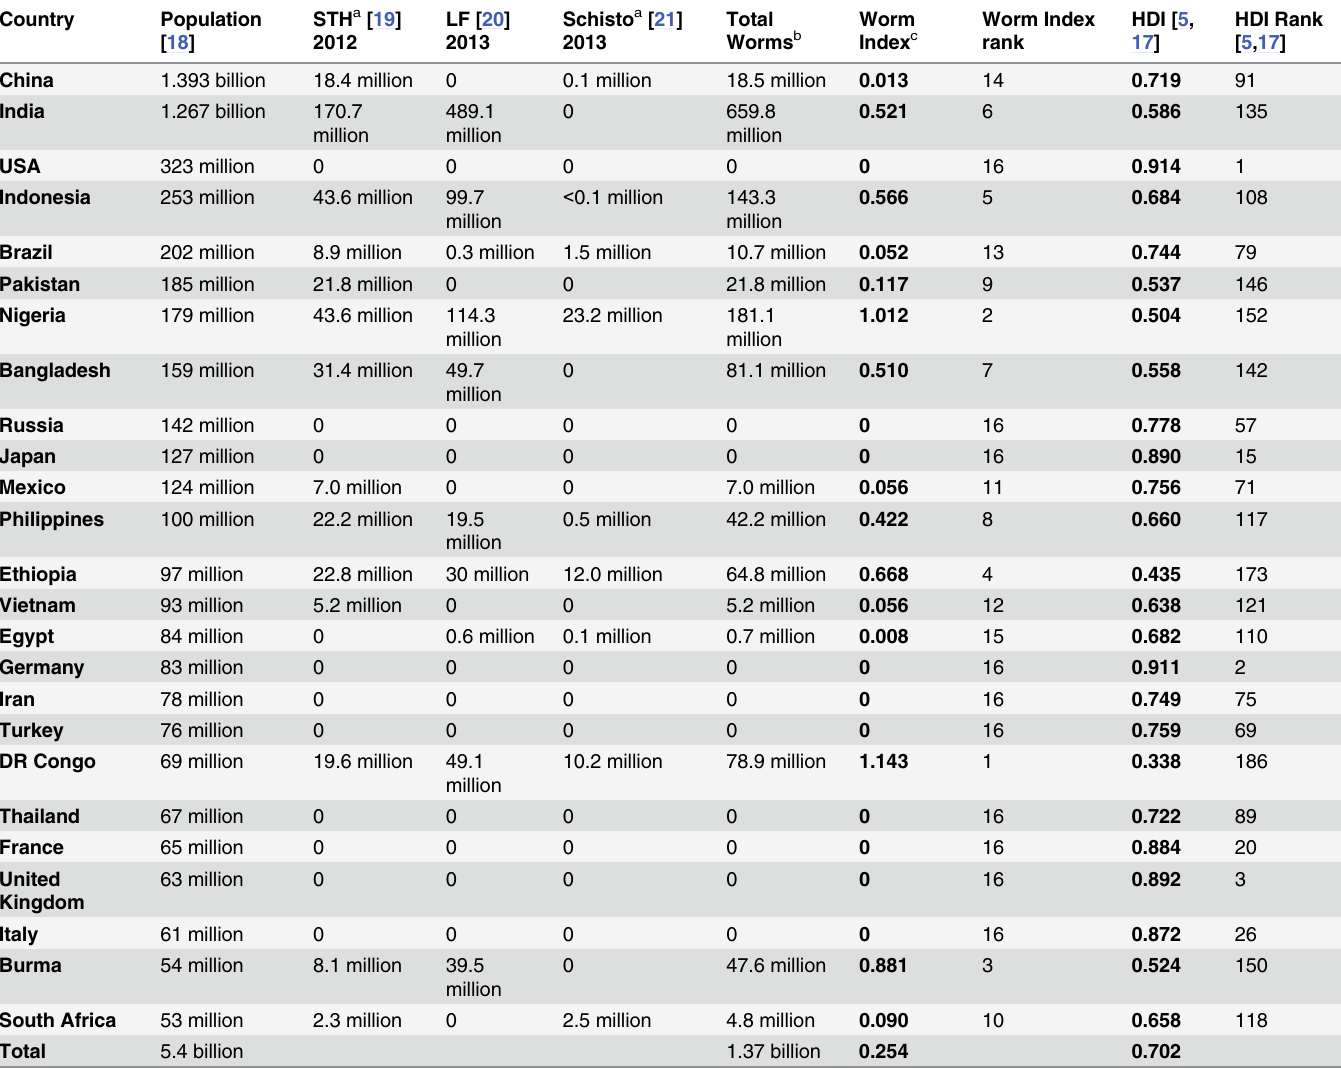
Table 1. The worm index and HDI in the world ’ s 25 most populated